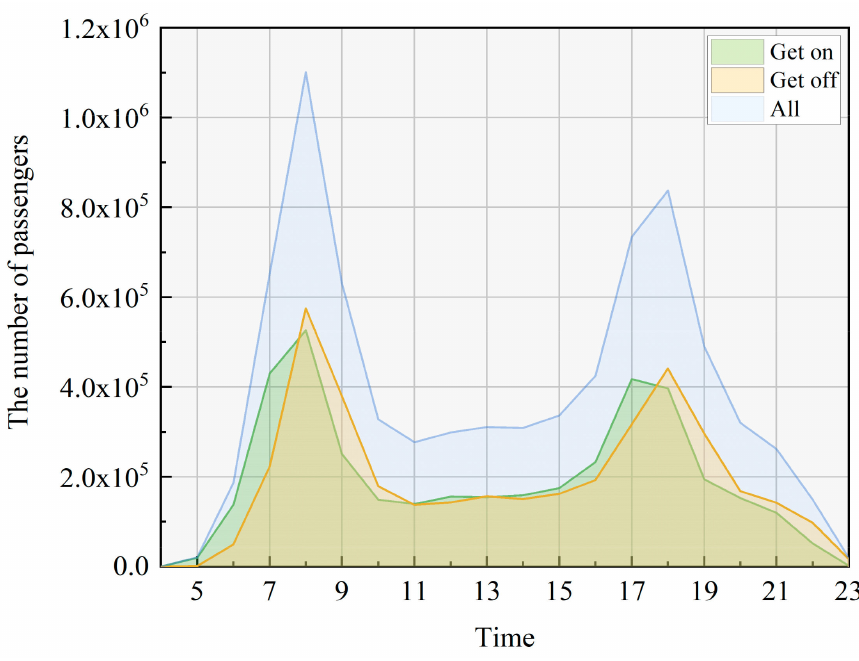
Figure A2. Average daily distribution of the passengers’ travel